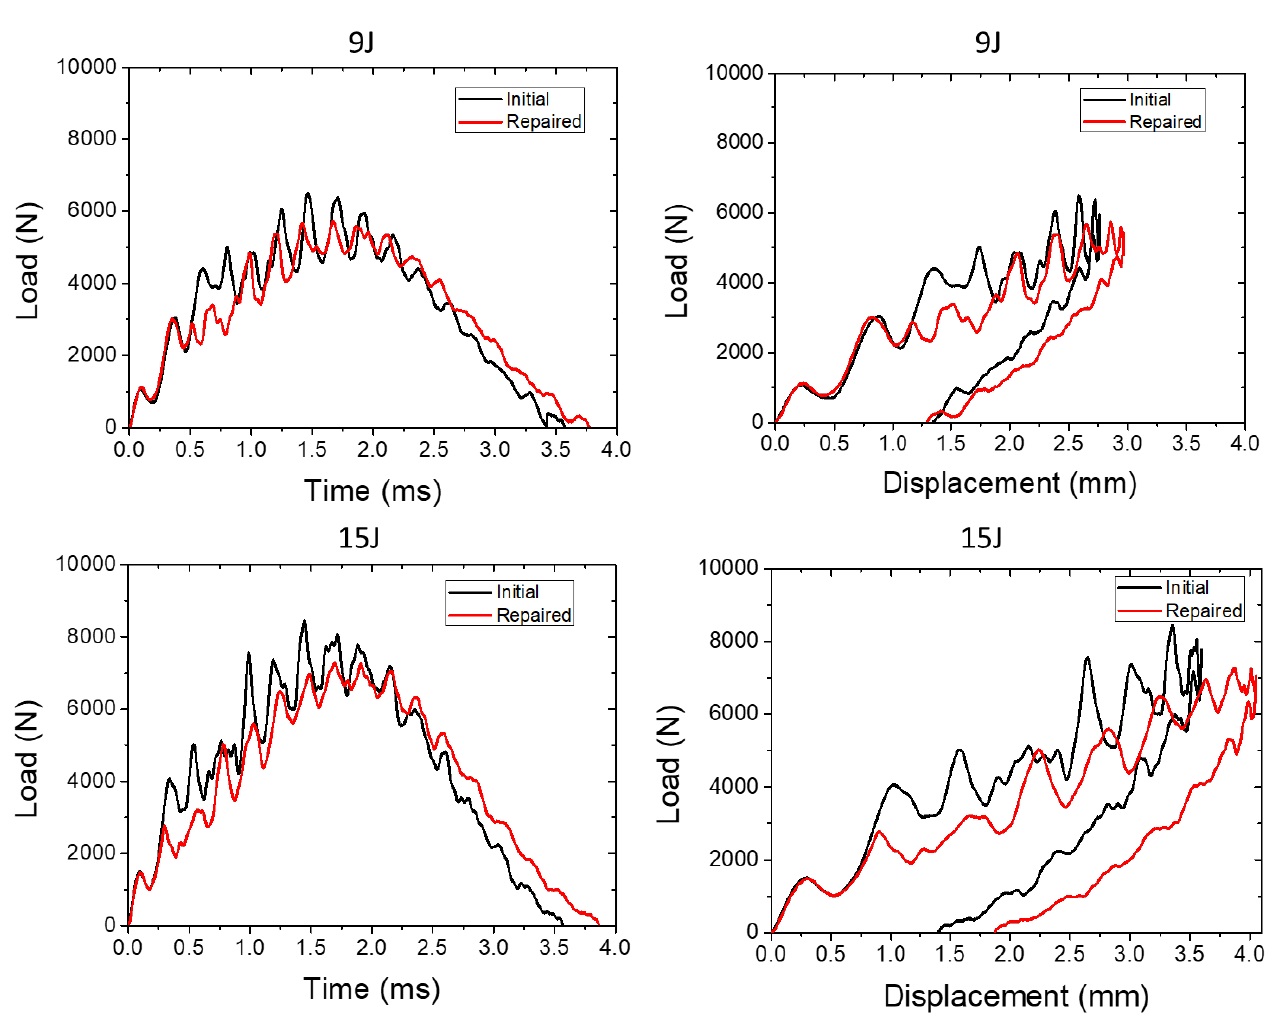
Figure 17. Representative load/time and load/displacement plots of impacts at 9 and 15 J of initial and repaired specimens. Table 4. Repair efficiency values of 9 and 15 J impacts.